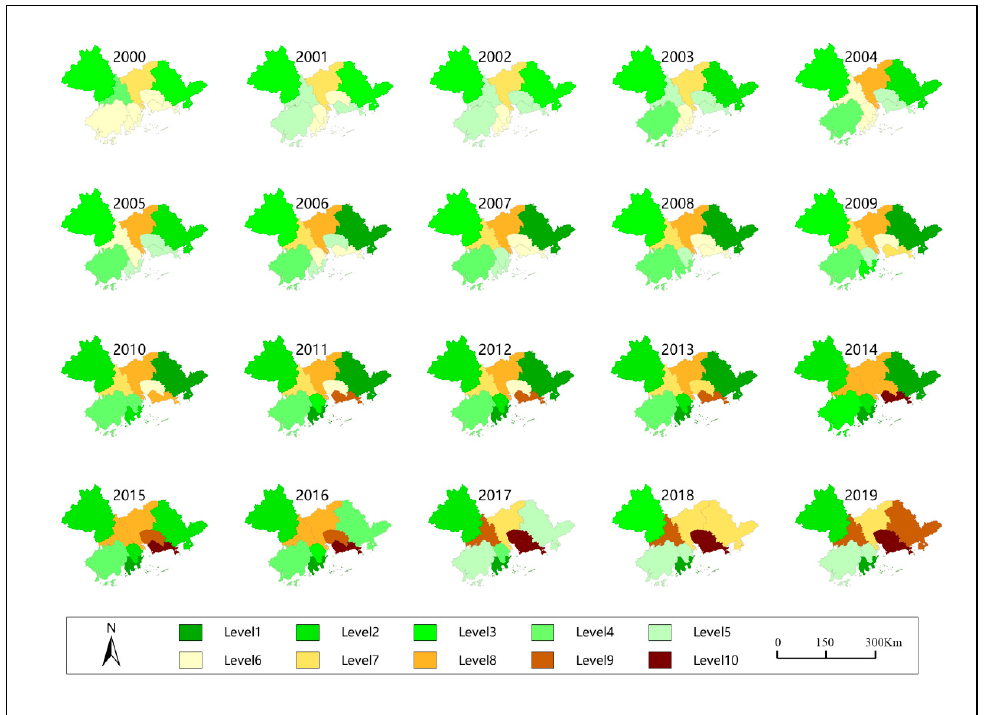
Figure 5. Level of the GTWR coefficient of production capability on the development of manufac- turing in different years. ing in different